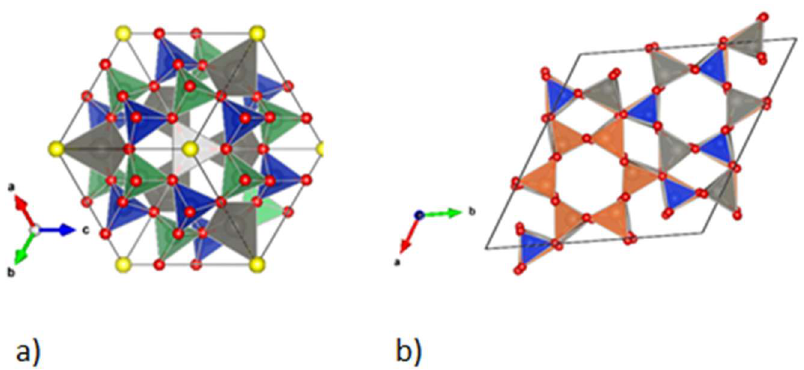
Figure 3. The sketches of the structure of studied minerals using Vesta 3 program and American Mineralogist Crystals Database, ( a ) genthelvite: sulphur—yellow, oxygen—red, ZnO 4 —grey, BeO 4 —green, SiO 4 —blue; ( b ) willemite: Zn 1 O 4 —orange, Zn 2 O 4 —grey, SiO 4 —blue.